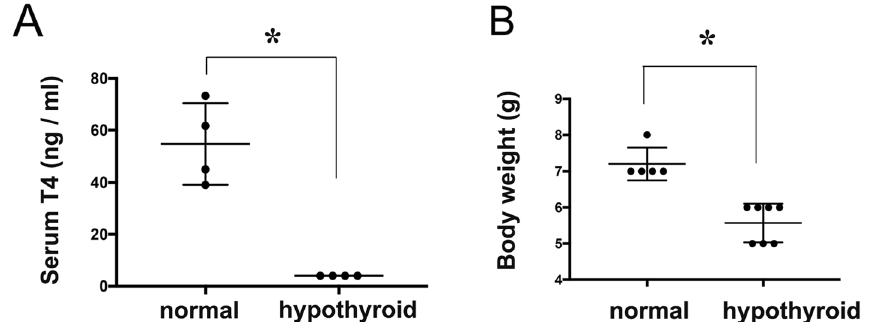
Figure 1. Effects of antithyroid agents on serum thyroxine levels and body weight of juvenile mice. ( A ) Graph shows the levels of serum thyroxine (T 4 ) in mice at postnatal day 14. Each group, n = 4; *p < 0.0001. ( B ) Graph shows the body weight of mice at postnatal day 14. Hypothyroid group, n = 7; control group, n = 5. *p <